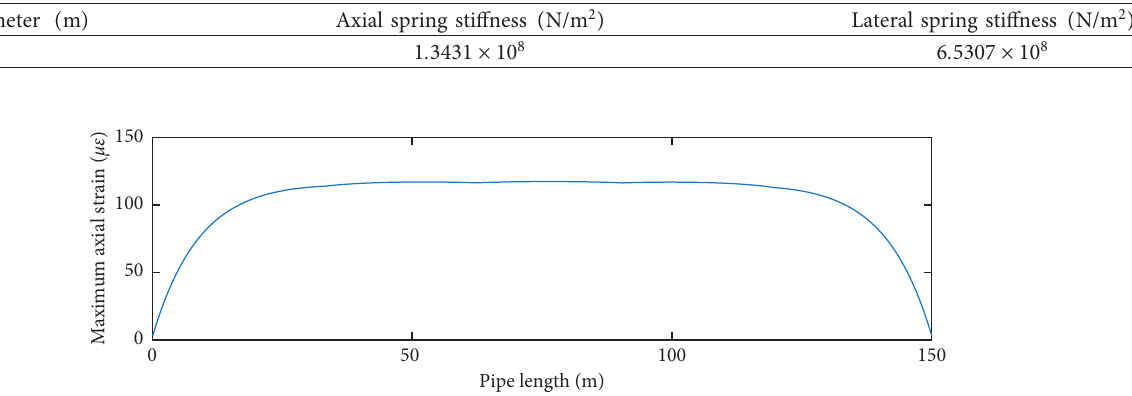
Figure 6: Maximum axial strain (site: IV; diameter: 406.4mm).